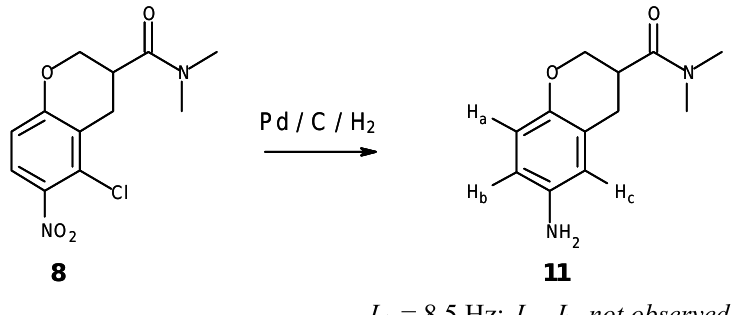
Figure 3. Determination of regiochemistry of nitration based on 1 H-NMR after